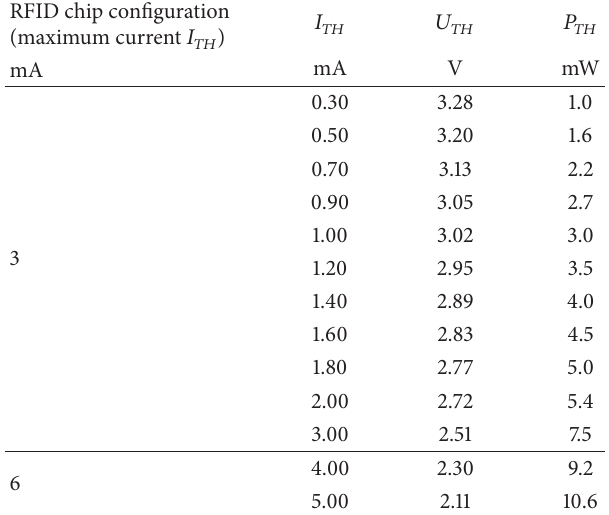
Table 2: Measurements of power efficiency for energy harvesting